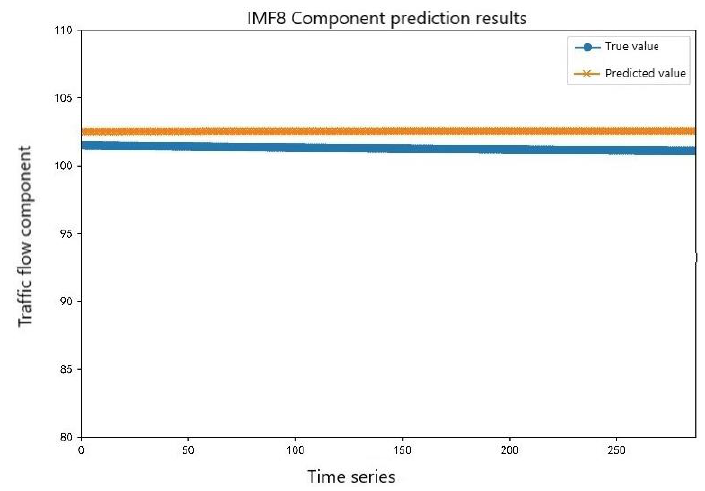
Figure 11. Prediction results of the low-frequency component sequences.